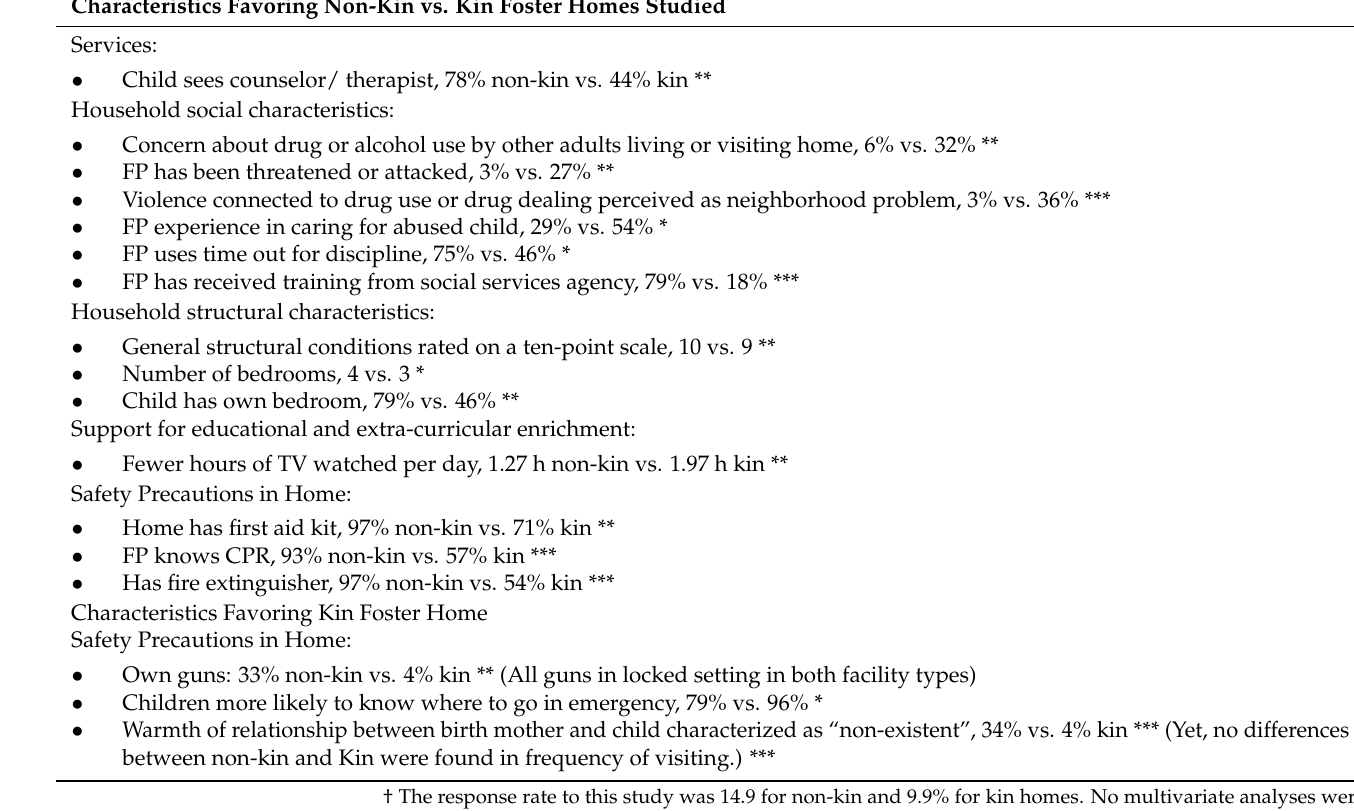
Table 1. Characteristics of non-kin vs. kin foster homes summarized from Berrick’s study [196] (N = 34 non-kin and N = 24 kin foster care placements).